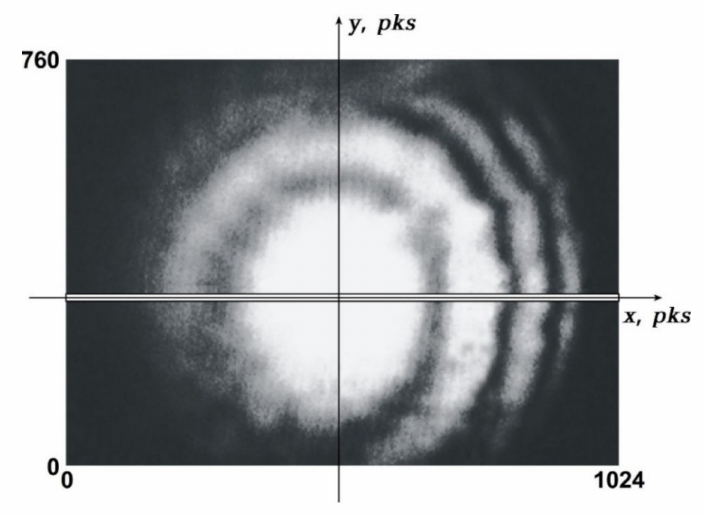
Figure 3. Image of interference